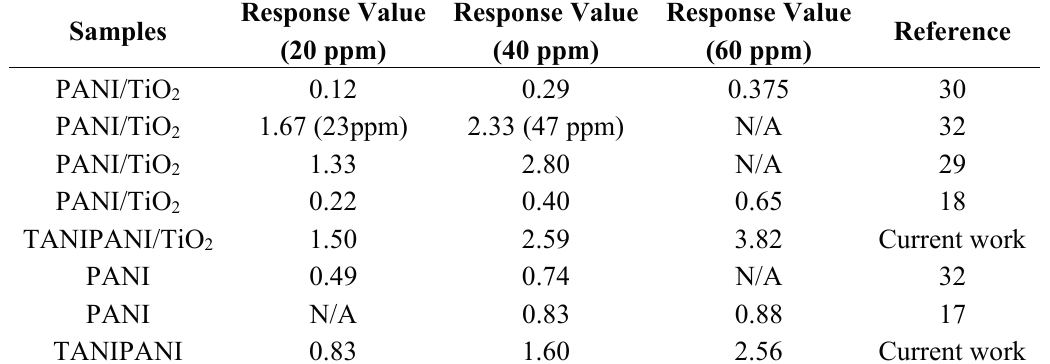
Table 1. Response values of some polyaniline and polyaniline-TiO 2 composites available in